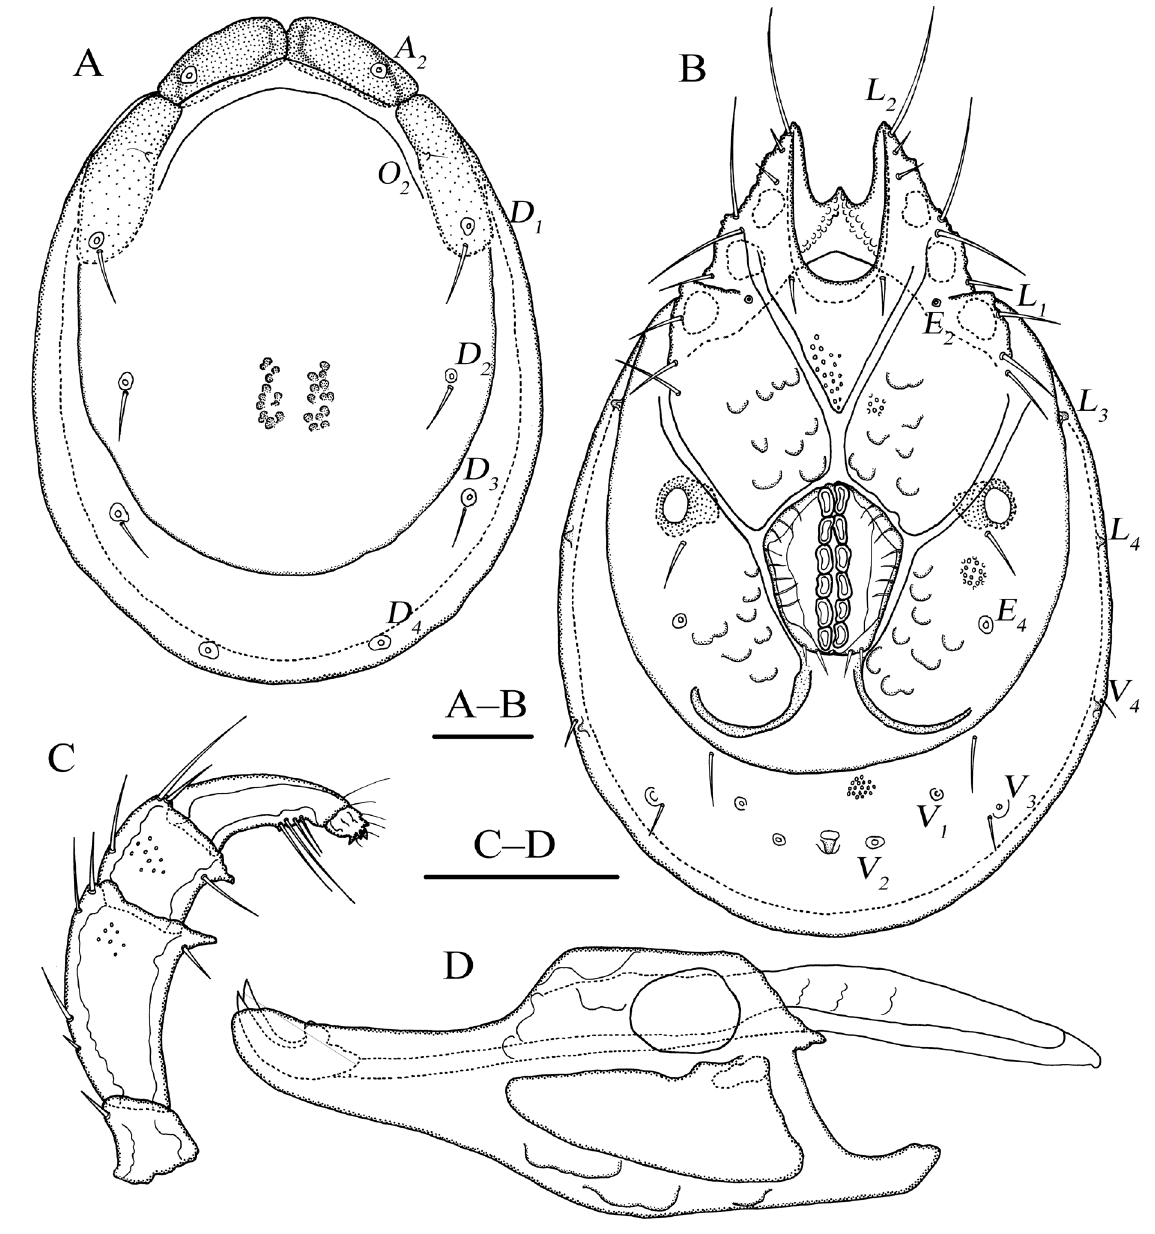
Fig. 11. Torrenticola wuyiensis Gu & Guo sp. nov., ♀, paratype (FJ-TO-20180812). A . Dorsal view. B . Ventral view. C . Palp, lateral view. D . Infracapitulum and chelicera. Scale bars = 100